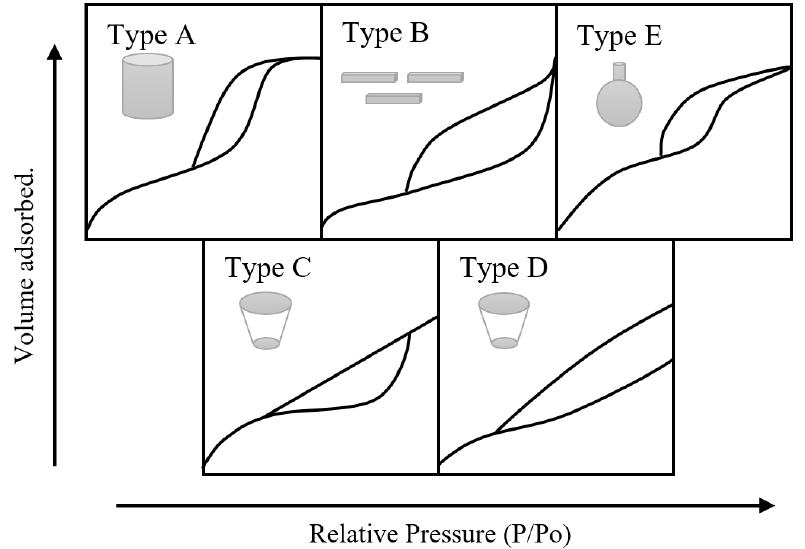
Figure 4. Five different types of hysteresis loop related to pore shapes. (Modified from Labani et al., 2013, and Zhang et al., 2016 [69,70]).